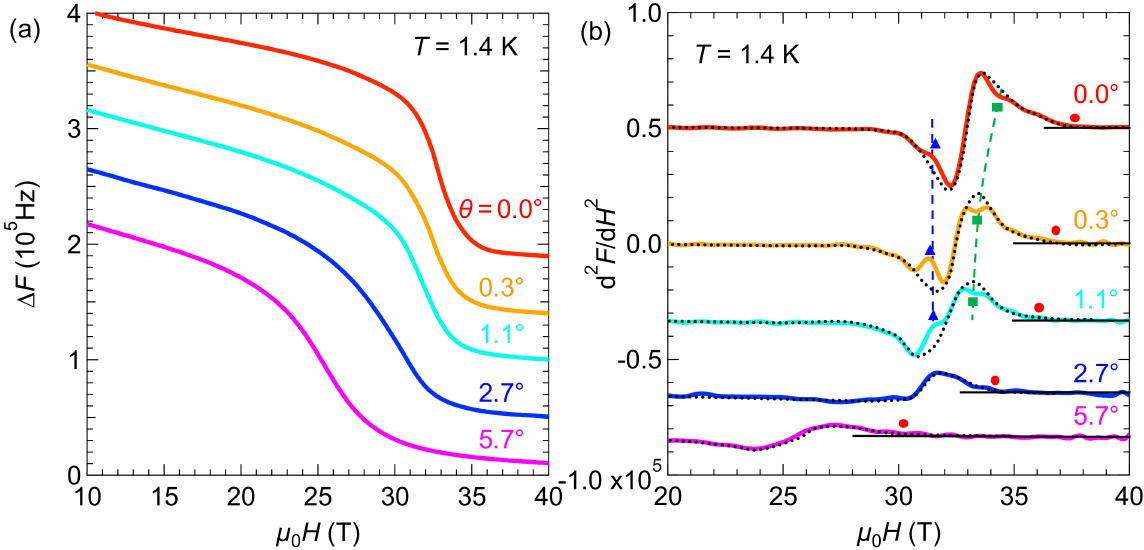
Figure 3. ( a ) Magnetic-field dependence of ∆ F at 1.4 K with changing field angle θ . ( b ) Second derivative of ( a ) d 2 F /d H 2 as a function of field. The black solid lines and the red dots show the background of the normal state and H c2 . The blue triangles and green squares indicate the anomalous fields of d 2 F /d H 2 . The black dotted, blue dashed, and green dashed curves are eye